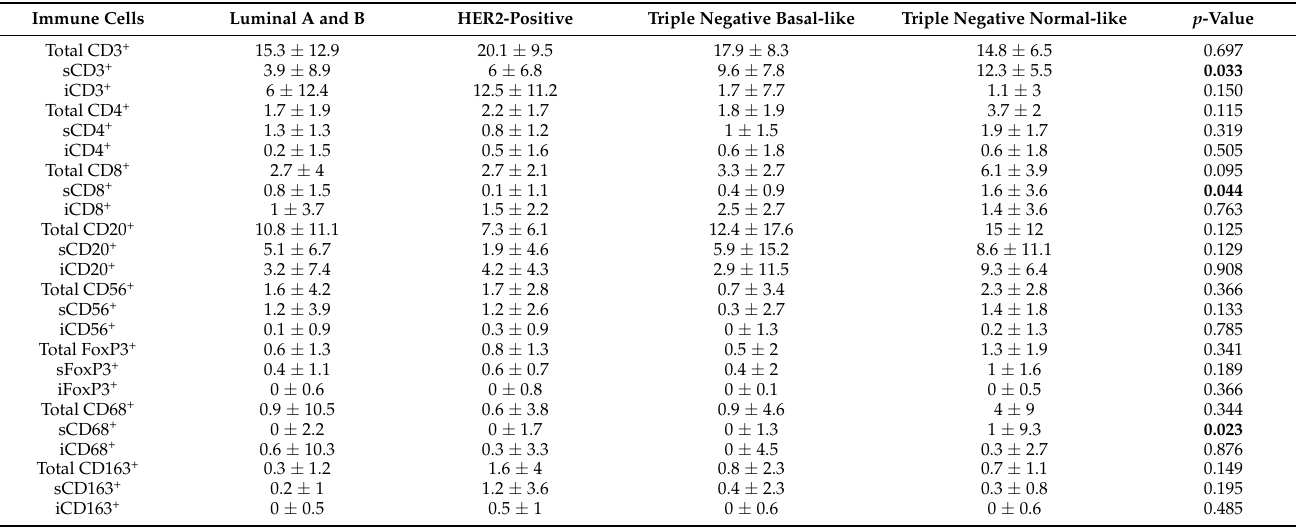
Table 4. The median ± standard deviation (SE) values of positive immune cell phenotype related proteins according to the feline mammary carcinoma molecular